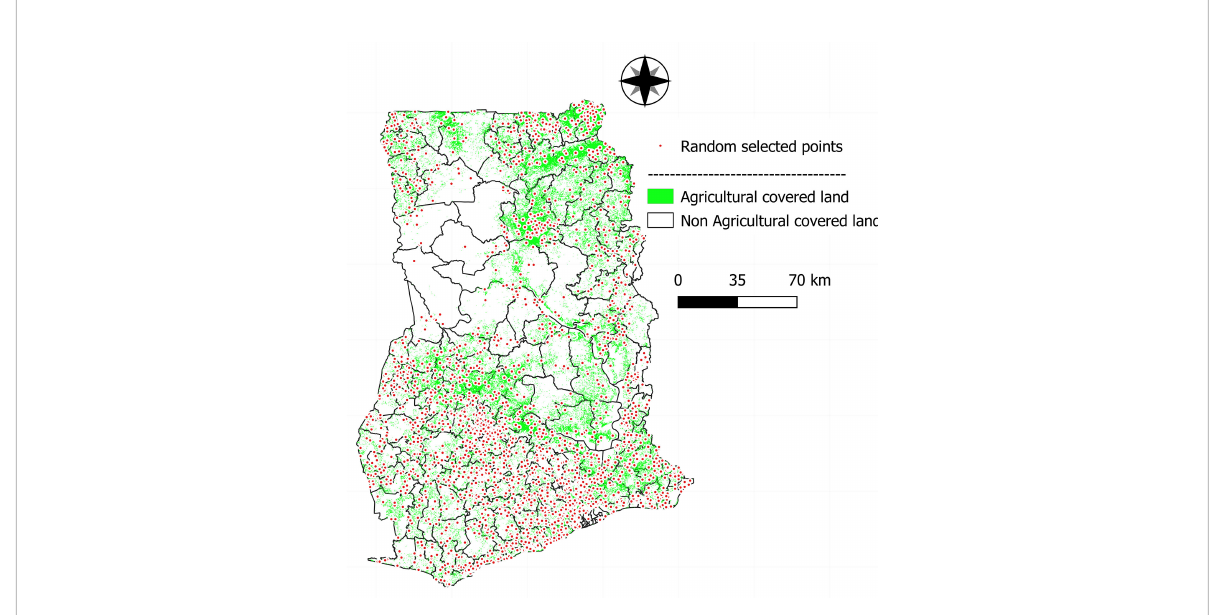
FIGURE 3 Randomly selected points at district level in Ghana for maize potential yield and yield gap